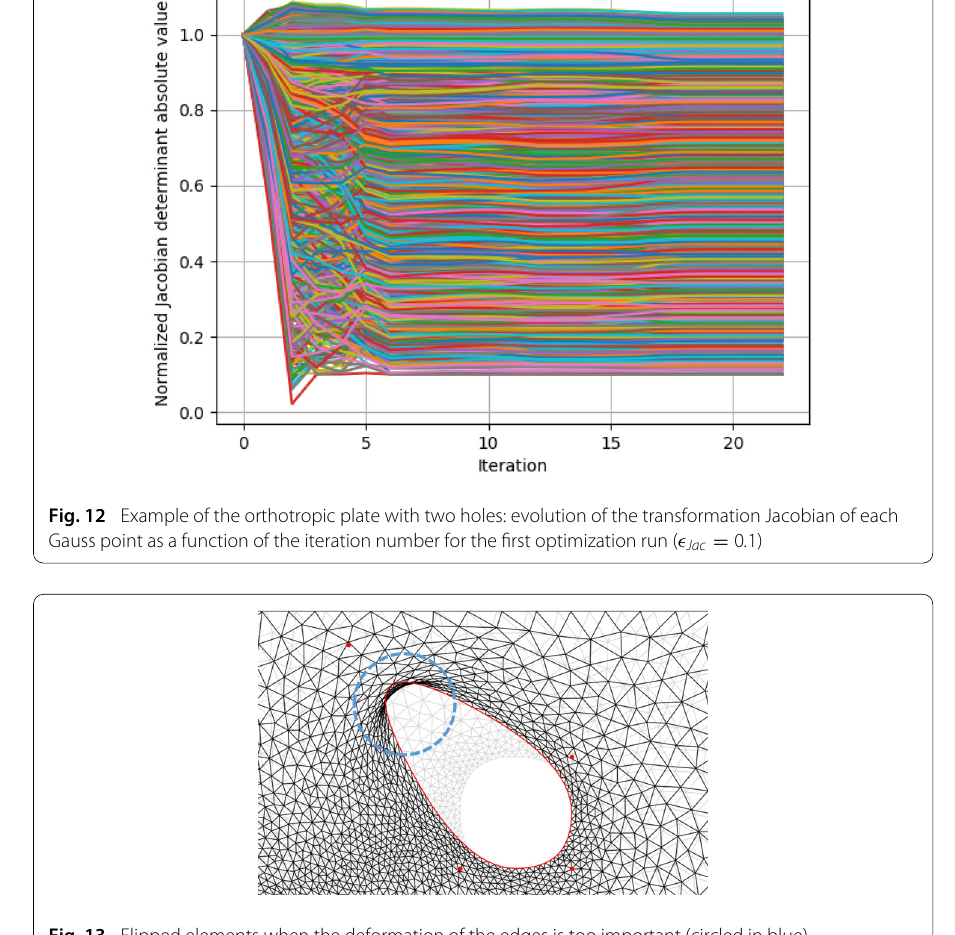
Fig. 13 Flipped elements when the deformation of the edges is too important (circled in